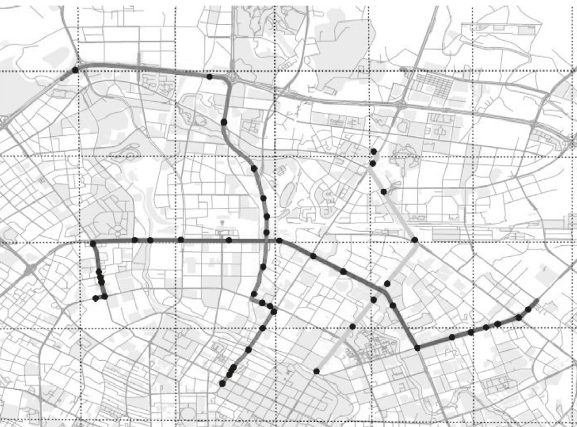
Figure 4: Map of the vehicle trajectory.